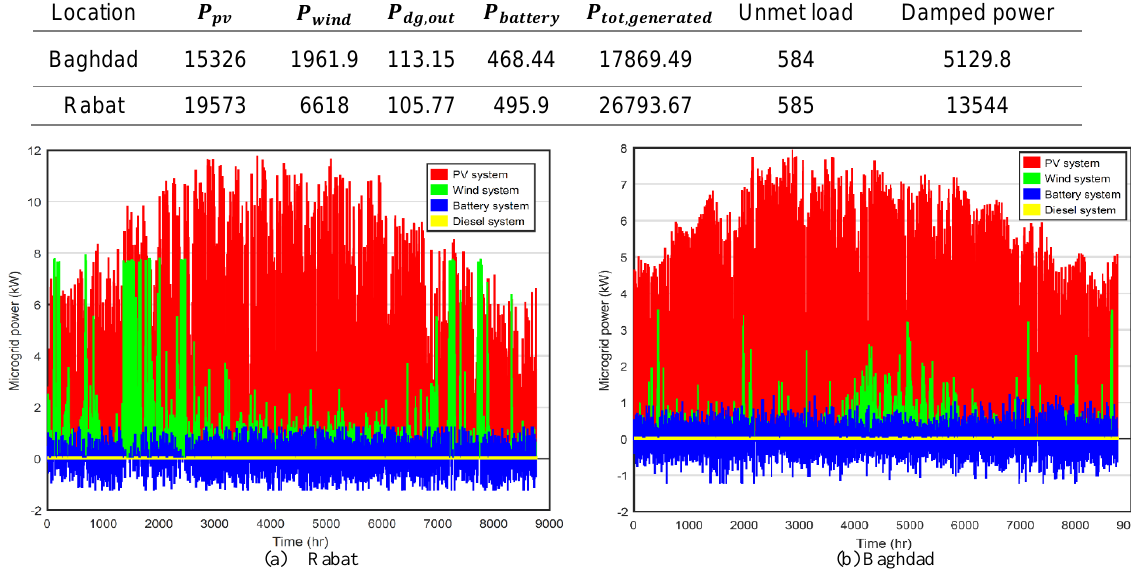
Figure 8 . Output power over a year